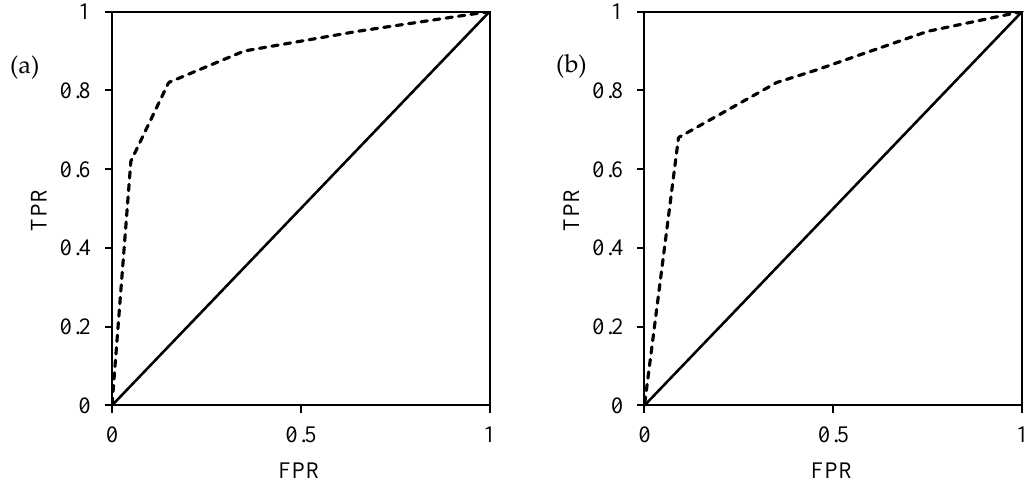
Figure 9. Receiver Operating Characteristic–Area under the Curve (ROC–AUC) curves of drought classification: ( a ) SPEI 1 and ( b ) SPEI 3 for the study region.